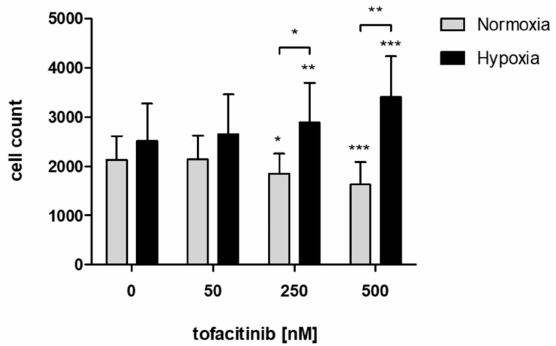
Figure 1. JAK inhibition by increasing doses of tofacitinib resulted in an increase of migrated hMSCs under hypoxic incubation conditions but reduced hMSC-migration under normoxia. Counts of migrated cells ( n = 6; mean ± SEM; * p < 0.05, ** p < 0.01, *** p < 0.001; two-way ANOVA with Bonferroni post hoc test); asterisks above columns indicate comparison to the respective untreated control = 0 nM tofacitinib).